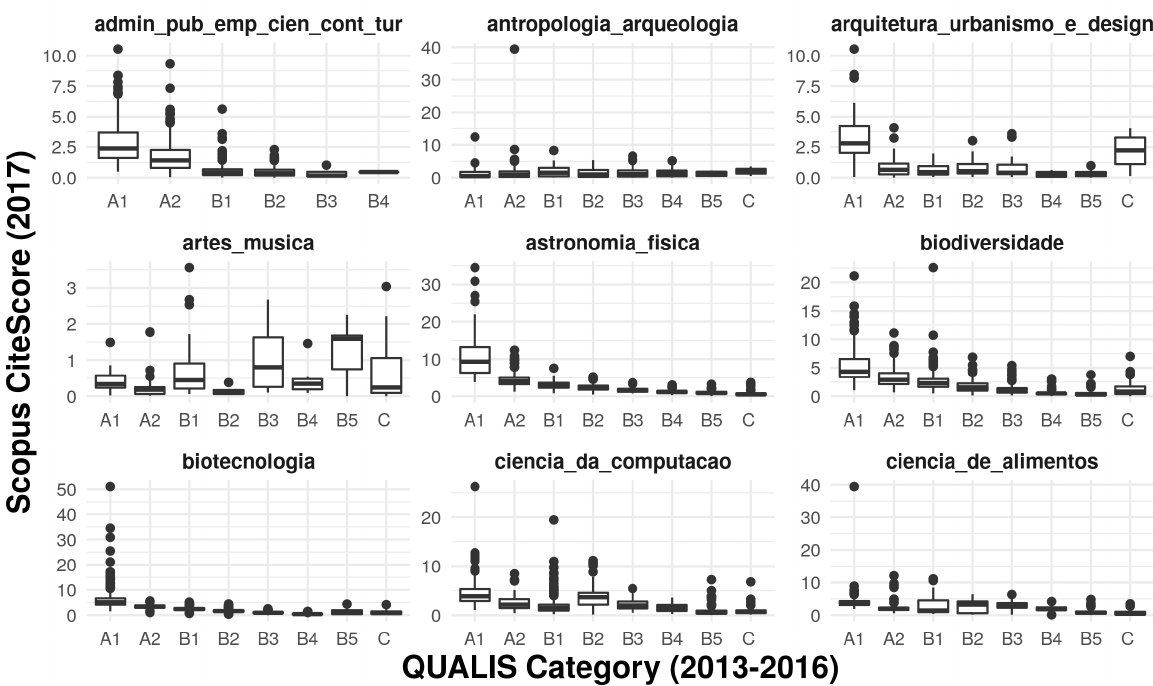
Figure 3. Scopus CiteScore variation across QUALIS categories in nine subject area. Original QUALIS subject area names are shown (as written in their respective classification sheets) but their English translation can be found in Table SI.